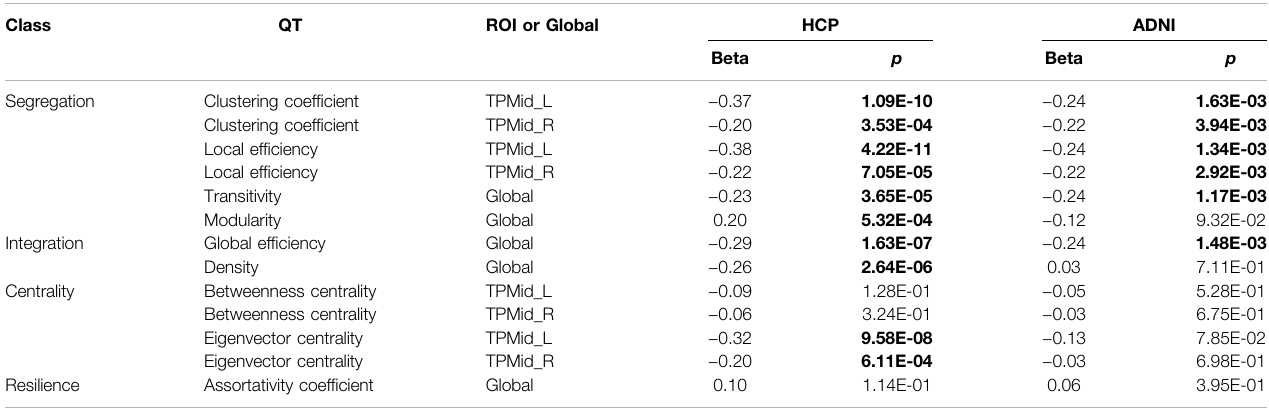
TABLE 3 | Associations between rs7937515 and brain network measures.